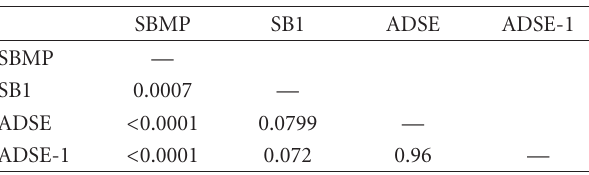
Table 4: Statistical di ff erences among the tested adhesives and level of significance ( P